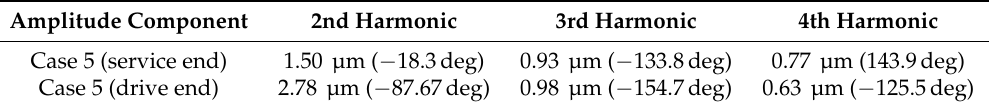
Table 6. Average amplitudes and phases of the two roller element paths (see Figure 5) used in Case 5 for the service end and the drive end. For the phase, the circular average was utilized.